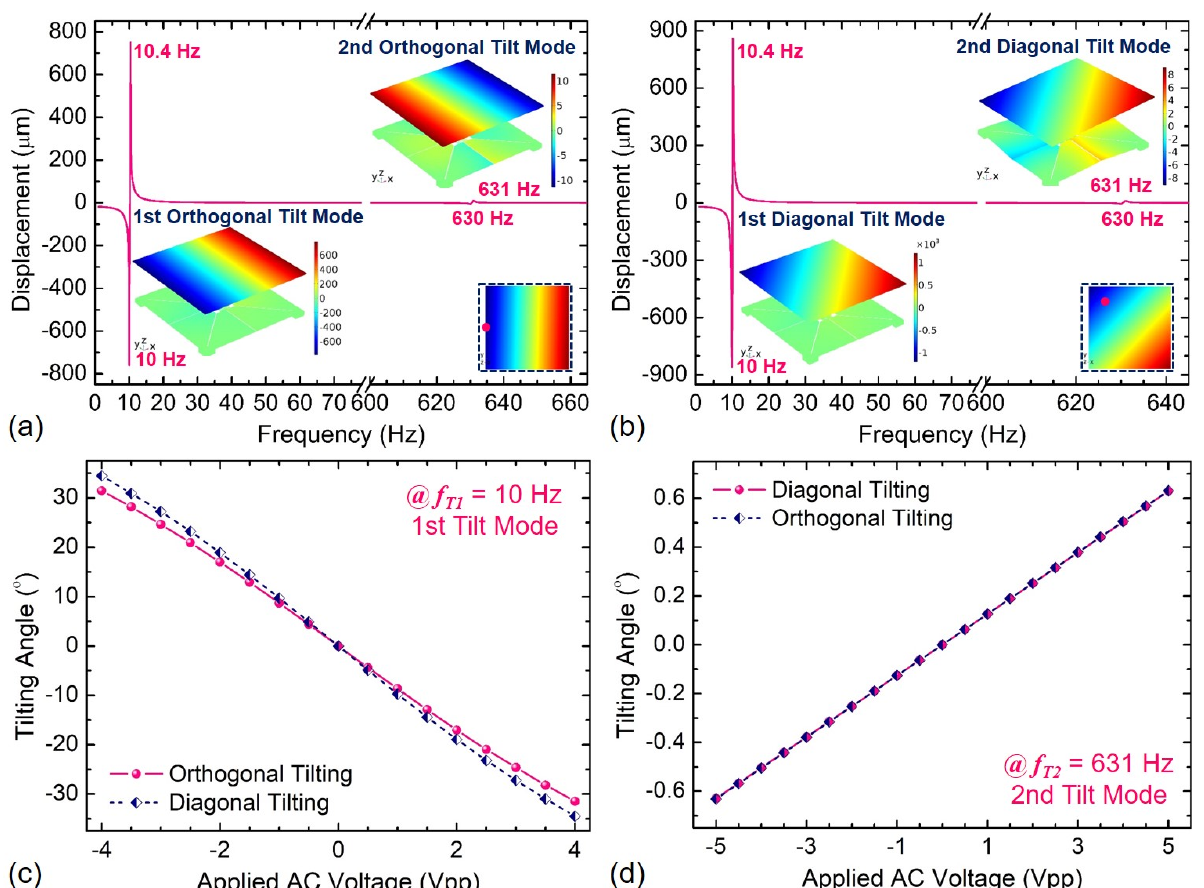
Figure 13. Frequency response of Device B: ( a , b ) displacement at the 1st and 2nd tilt modes, ( c , d ) tilting angle vs. applied AC voltage.